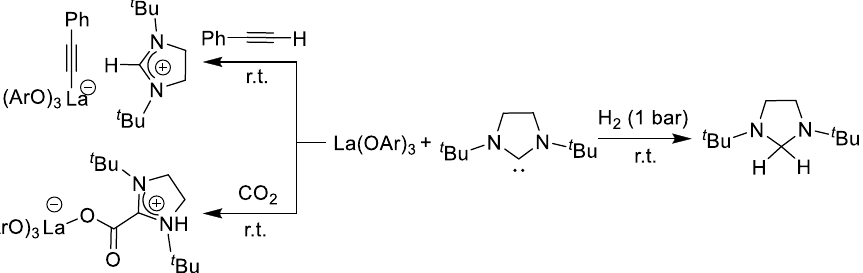
Figure 6. NHC-ligated Ln amides and phosphide used as catalysts for organic synthesis.